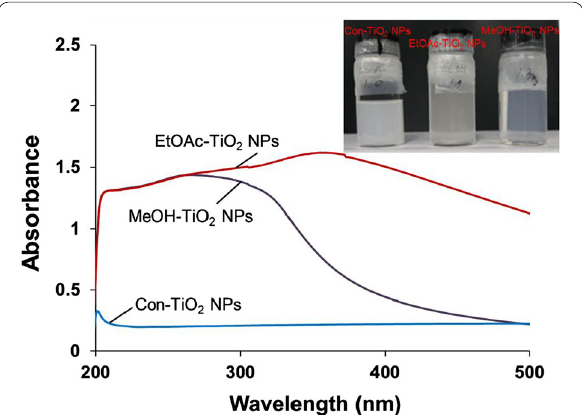
Fig. 1 UV–visible spectra of the calcinated TiO 2 NPs in ethanol. The black, red and blue lines indicate MeOH‑TiO 2 NPs, EtOAc‑TiO 2 NPs and Con‑TiO 2 NPs, respectively. The inset shows digital photography of each colloidal solution of Con‑TiO 2 NPs (left image), EtOAc‑TiO 2 NPs (middle image) and MeOH‑TiO 2 NPs (right